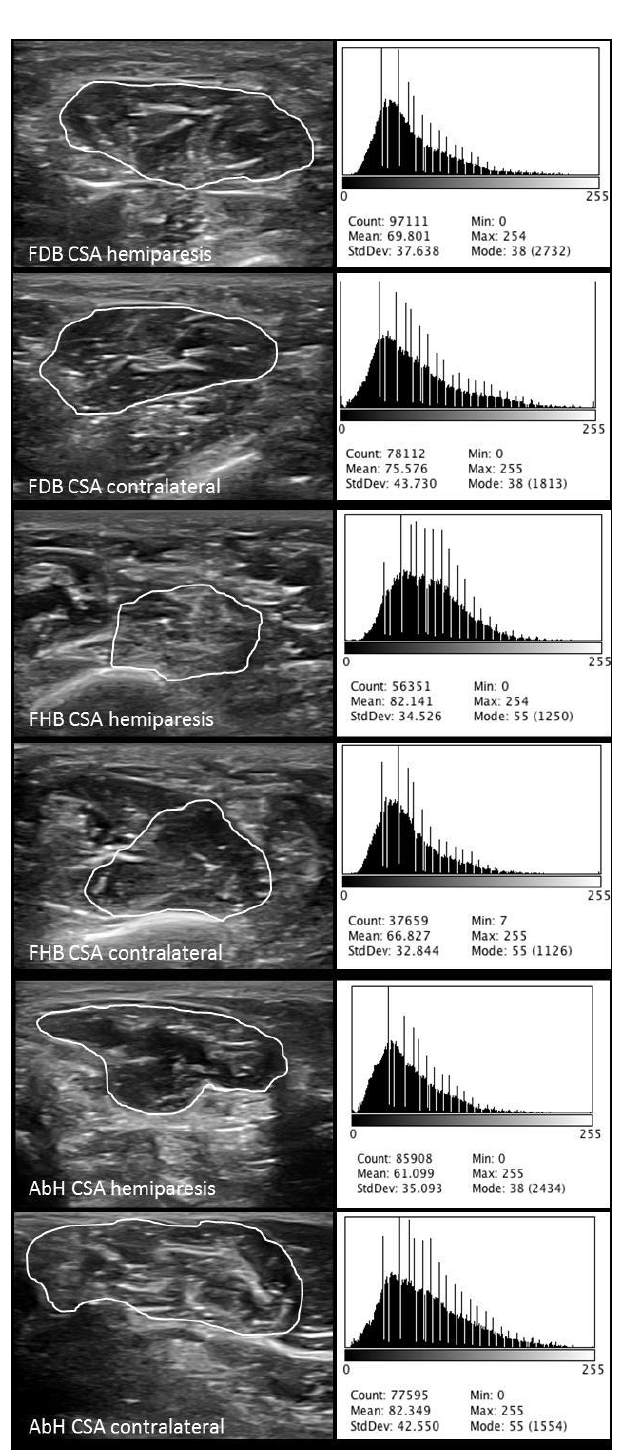
Figure 1. ImageJ software analysis of the CSA, mean, SD and count of the pixels from the FDB, FHB, and AbH of the hemiplegic and contralateral feet in poststroke patients. Abbreviations: AbH, abductor hallucis; CSA, cross-sectional area; FDB, flexor digitorum brevis; FHB, flexor hallucis brevis; SD, standard deviation.